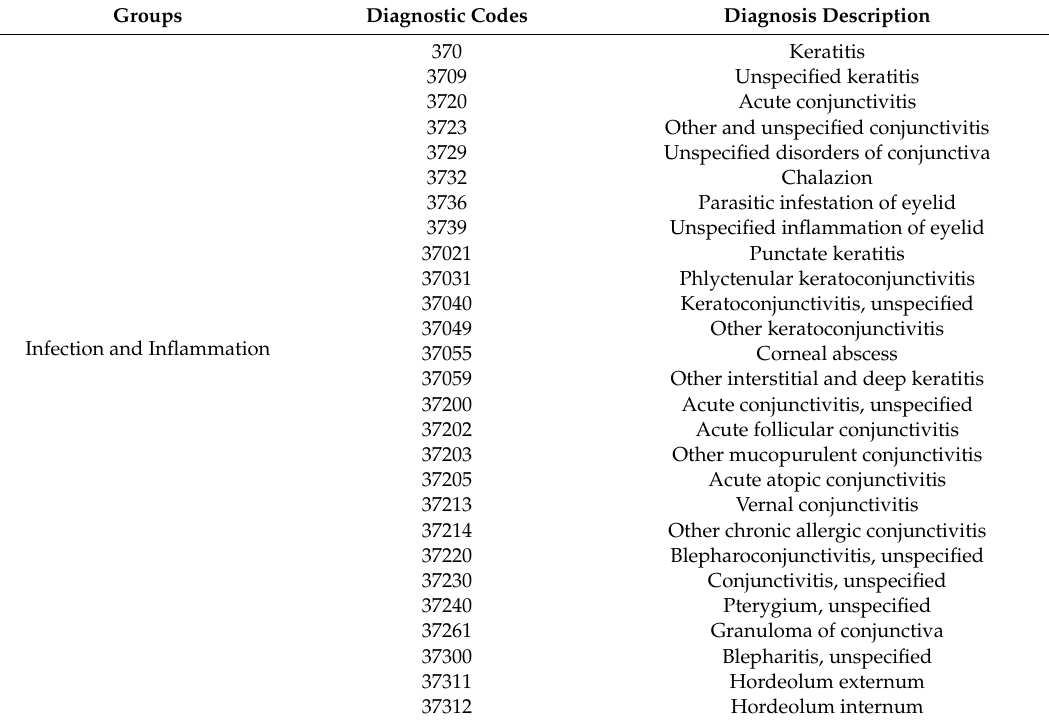
Table A1. ICD-9 Codes